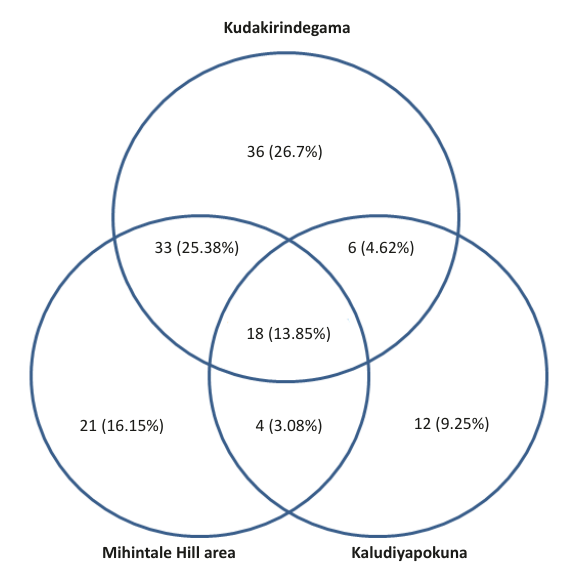
Figure 2. Species composition in different habitats within the Mihintale